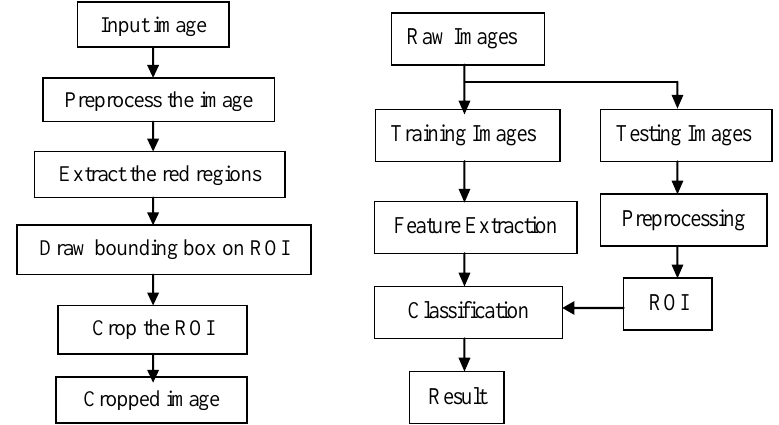
Fig.2. Proposed models to detect the traffic